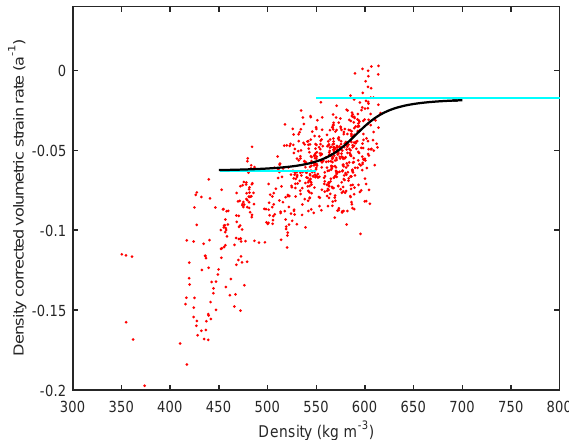
Figure 4. Measured values of F as a function of density for iSTAR Site 21 (red dots), values of c for Stage 1 and Stage 2 from the Herron and Langway model (cyan lines) and c as a function of density from the transition model with ρ T = 590 kg m − 3 , M = 2.8 (black